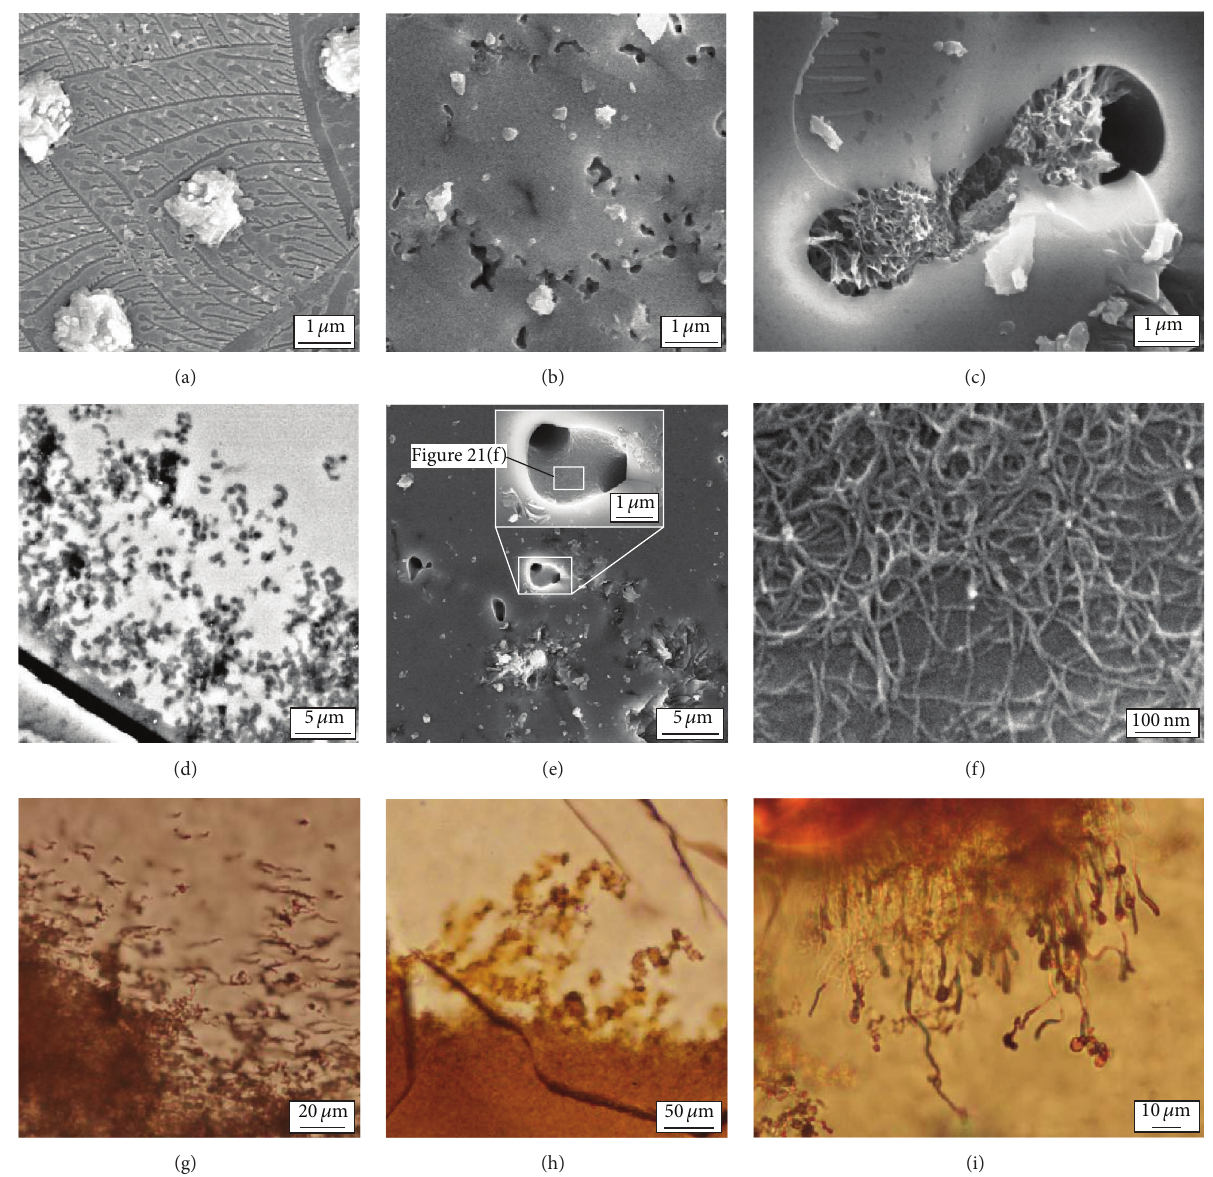
Figure 21: Summary of complex “abiotic” microtextures found in DSDP 418A basaltic glass that have the potential to be mistaken for signs of microbial activity (i.e., microbial etchings, groovings, borings, alteration, or remains). (a–c, e, f, h, and i) are from sample DSDP-418A- 75-3-[120–123] and (d, g) are from sample DSDP-418A-68-3[40–43] . (a–f) are SEM (secondary electron) images ((a–c, e, and f) are from basaltic glass “chip samples” and (d) is from a polished petrographic section) and (g–i) are transmitted light photomicrographs of polished sections taken in plane polarized light (uncrossed polars). (a) Dendritic nanogrooves on a vesicle wall (close-up image from Figure 1(b) in French and Muehlenbachs [107]) that represent frozen viscous fingers of magmatic fluid injected into the vesicle wall upon quenching of the glass. (b) Alpha-recoil track etch-tunnels (ARTETs). (c) A fission track etch-tunnel. (d) Granular palagonite ART alteration (close-up from Figure 2(b)). (e) ARTETs at the glass-palagonite interface affected by prolonged overetching and/or are “pressure solution